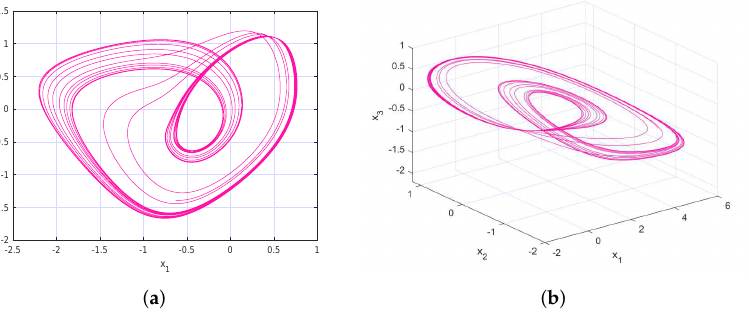
Figure 4. Phase portraits of: ( a ) Projection of chaotic attractors on x 1 − x 2 ; ( b ) Chaotic attractors on x 1 − x 2 − x 3 .